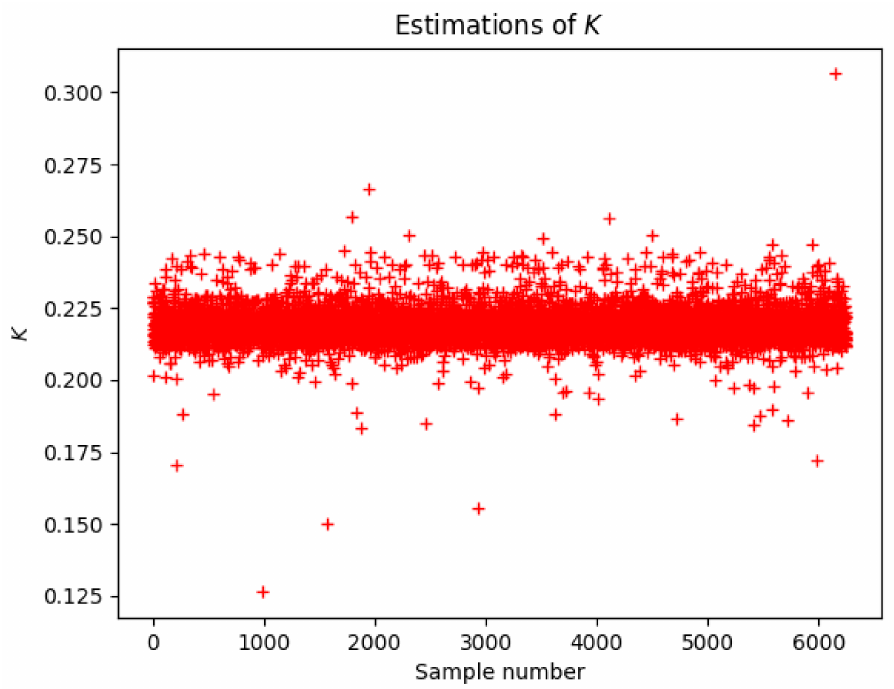
(cid:16) (cid:17) Q , dP pair data. The final estimation is dL